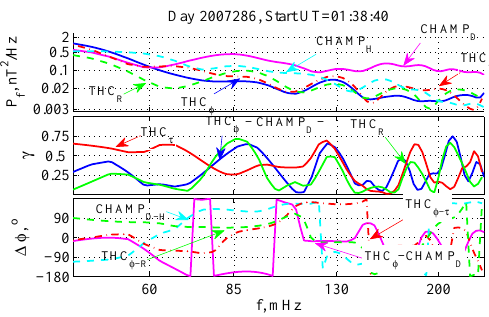
Figure 7. PSD spectra, spectral coherence, γ , and phase difference, (cid:49)ϕ , for the three THEMIS-C and the two horizontal CHAMP com- ponents for the interval shown in Fig.